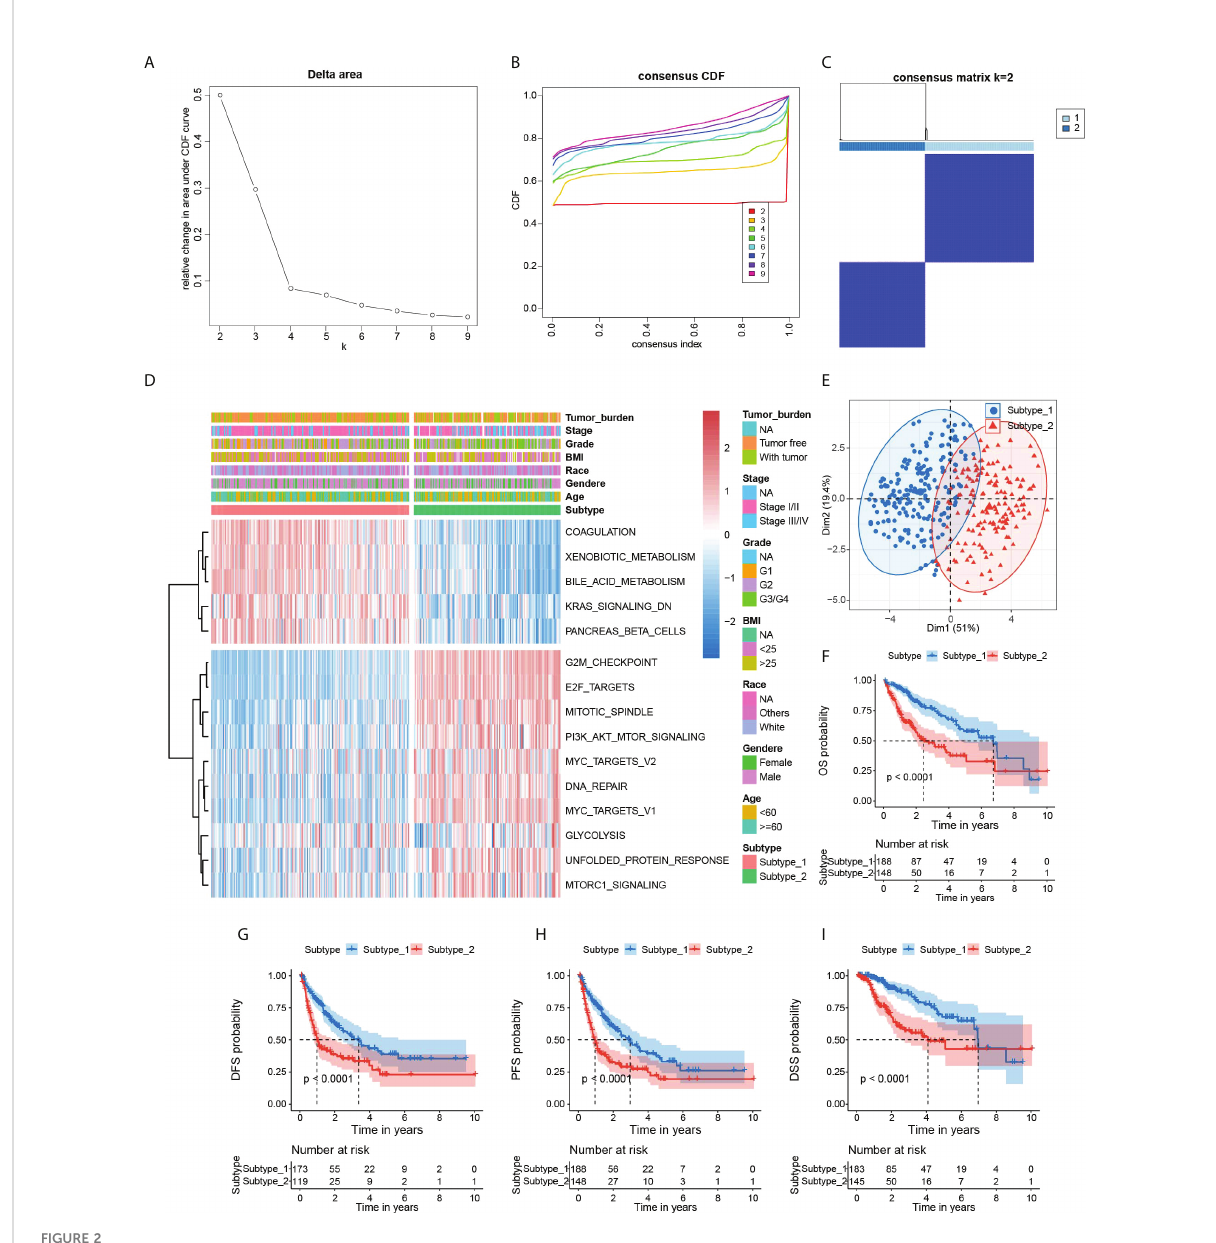
FIGURE 2 Identi fi cation of hallmark-based HCC subtypes . (A) The corresponding relative change in area under the cumulative distribution function (C, D, F) curves and the optimal number of cluster( k ) was 2. (B) Consensus clustering CDF for k = 2 to 9. (C) Heatmap of sample clustering at consensus k = 2. (D) Heatmap showing the GSVA score of 15 hallmark gene sets, tumor burden, stage, grade BMI, race, gender, and age in two subtypes of HCC. (E) PCA plot visualizing the two HCC subtypes with 15 hallmark gene sets. (F – I) Kaplan – Meier survival plots of subtype 1 and subtype 2 for OS, DFS, PFS, and DSS. OS, overall survival. DFS, disease-free survival. PFS, progression-free survival. DSS, disease-speci fi c survival. PCA, principal component analysis. GSVA, Gene set variation